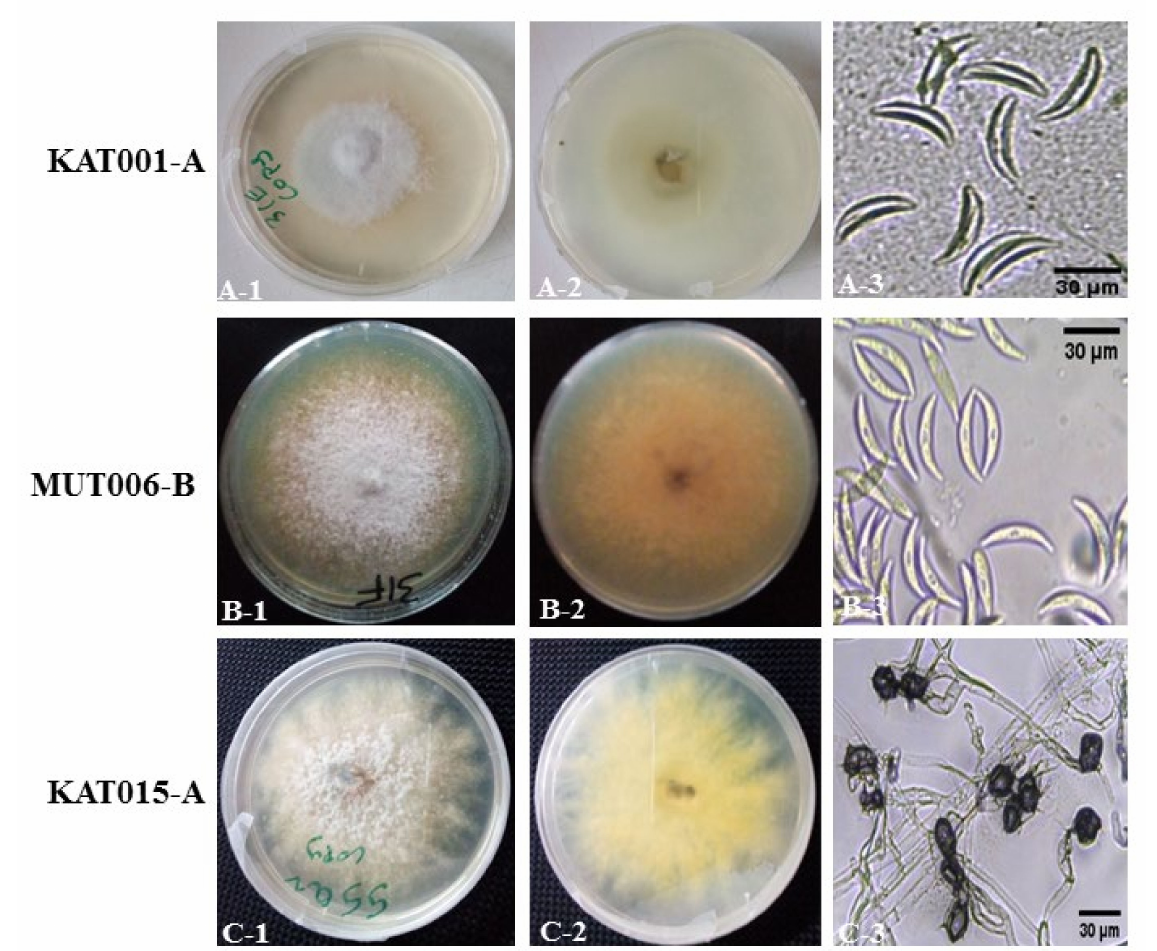
Figure 1. Morphological variability in the colonies of Colletotrichum isolates associated with sorghum anthracnose. KAT001-A, MUT006-B and KAT015-A are the representative isolates of the three groups. Each row from left to right: views of the top and bottom of potato dextrose agar (PDA) plate of representative isolates and conidia. ( A-1 , A-2 ) (KAT001-A) white both at top and reverse view; ( B-1 , B-2 ), (MUT006-B) white top view and salmon orange on the reverse view and ( C-1 , C-2 ), (KAT015-A) white and cottony on the upper view and yellow on reverse view with filamentous mycelial growth. ( A-3 ), Falcate, smooth and hyaline conidia; ( B-3 ), Hyaline, falcate, smooth